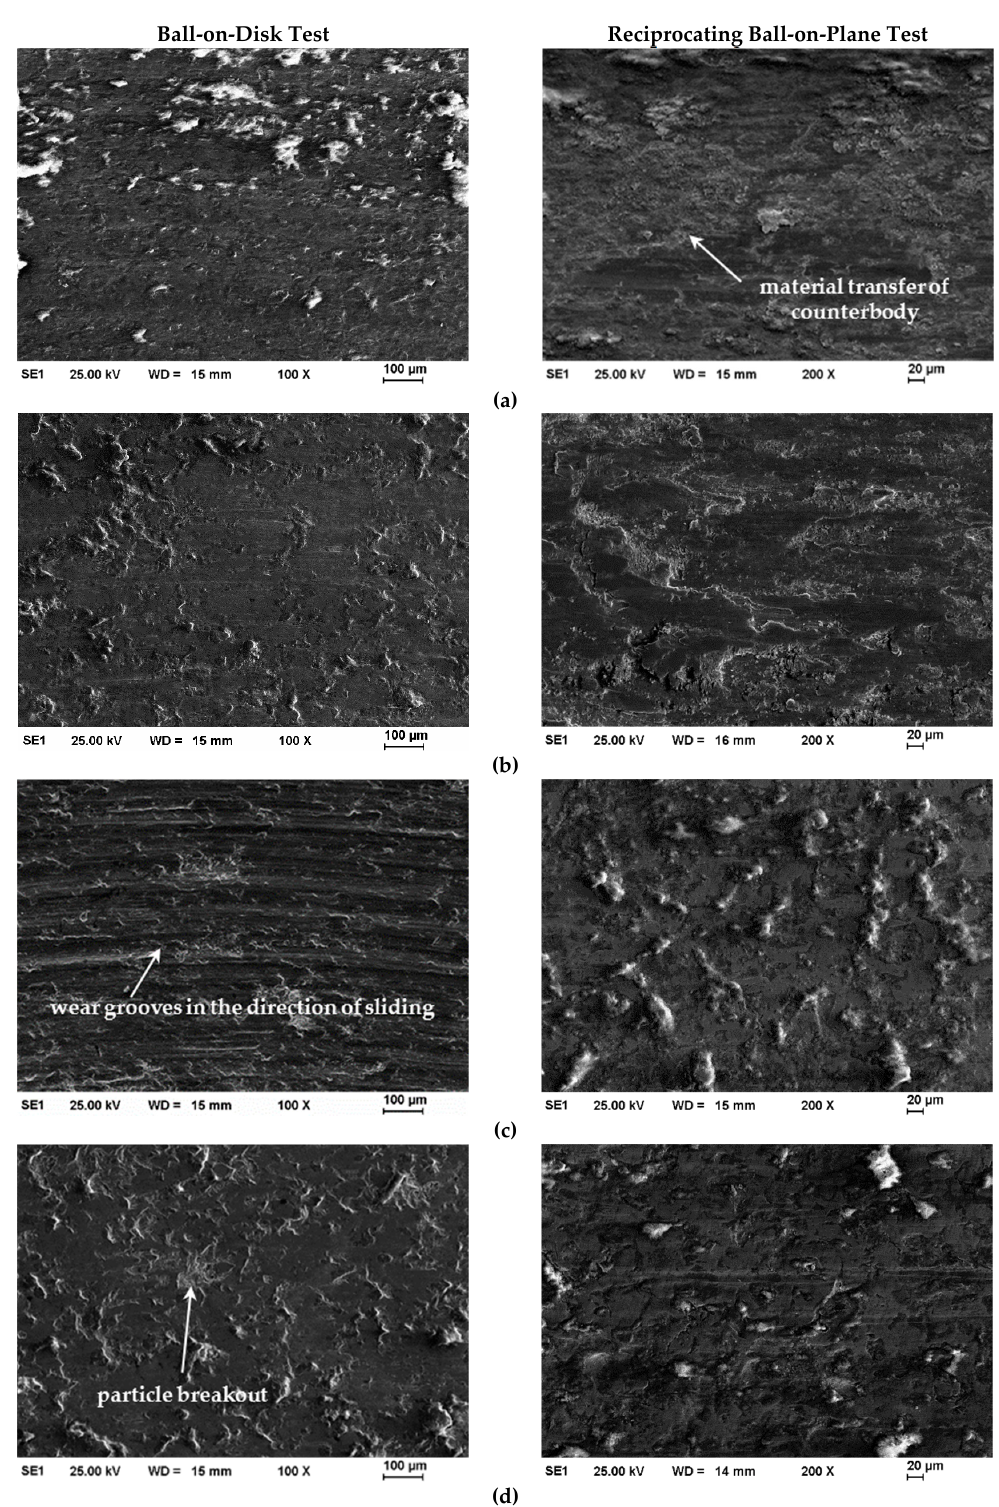
Figure 5. SEM micrographs of the wear tracks of AISI 316L coatings before and after gas nitriding after the ball-on-disk and reciprocating ball-on-plane tests. ( a ) AISI 316L HVOF coating in untreated condition; ( b ) AISI 316L HVOF coatings after gas nitriding at 420 °C/10 h; ( c ) AISI 316L HVOF coatings after gas nitriding at 420 °C/10 h PM; ( d ) AISI 316L HVOF coatings after gas nitriding at 420 °C/10 h PM + C.